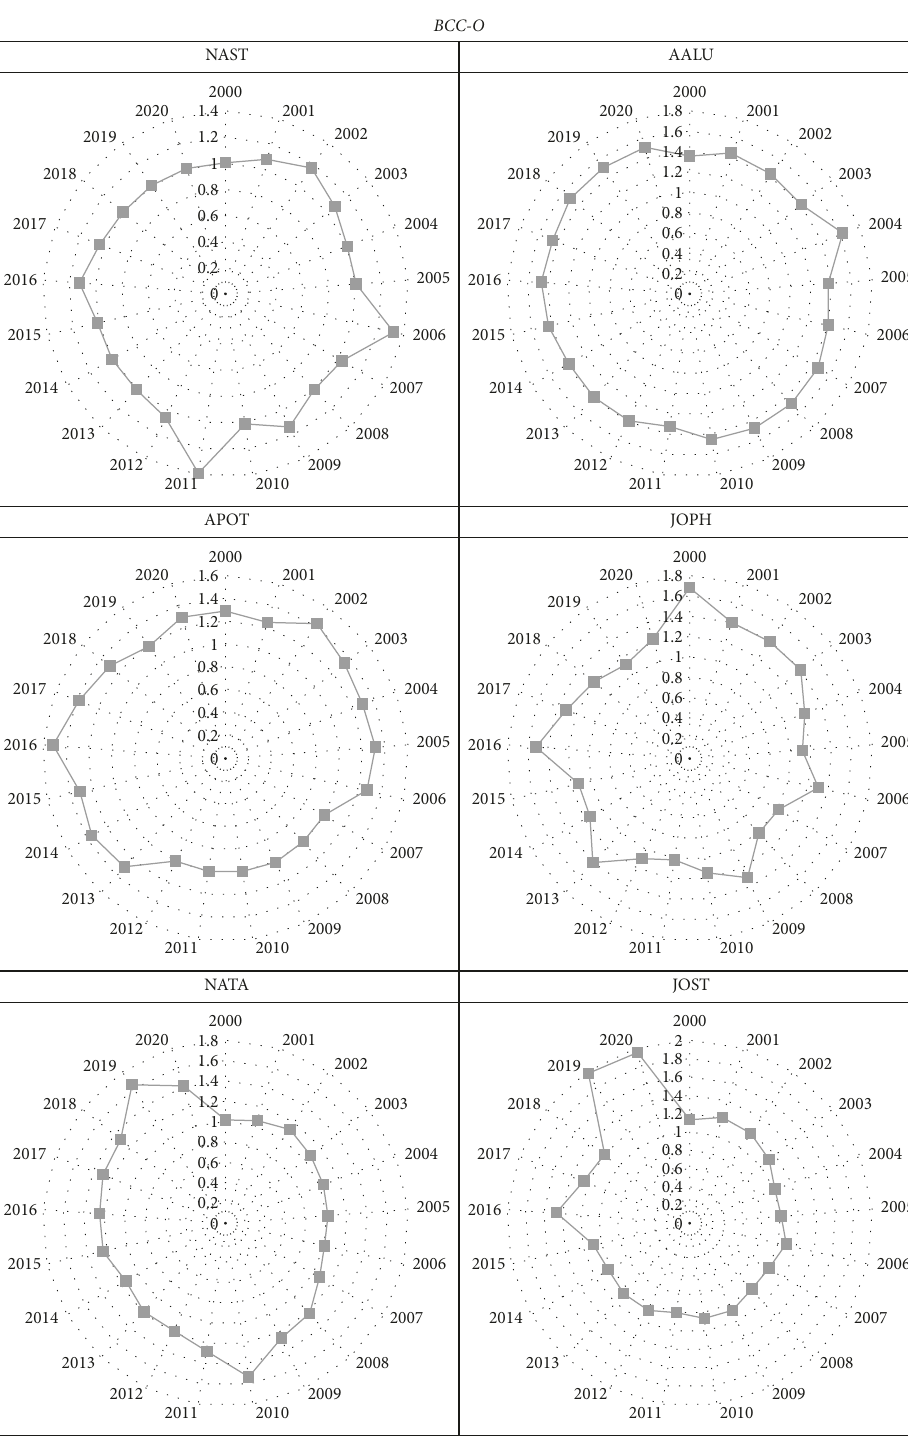
Figure 2: The efficiency rate for each company of BCC-O model during